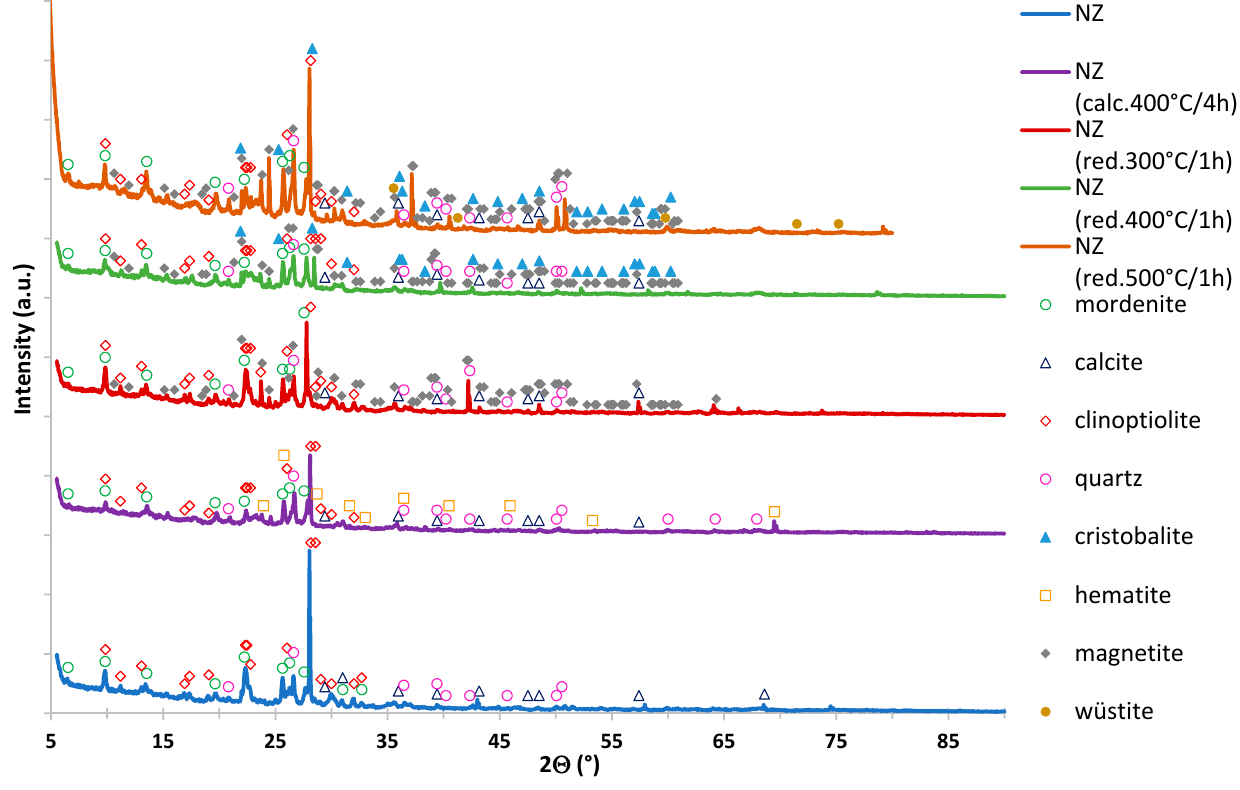
Materials 2021 , 14 , x FOR PEER REVIEW Figure 1. XRD analysis of the pristine natural zeolite and NZ zeolite after various treatment conditions.